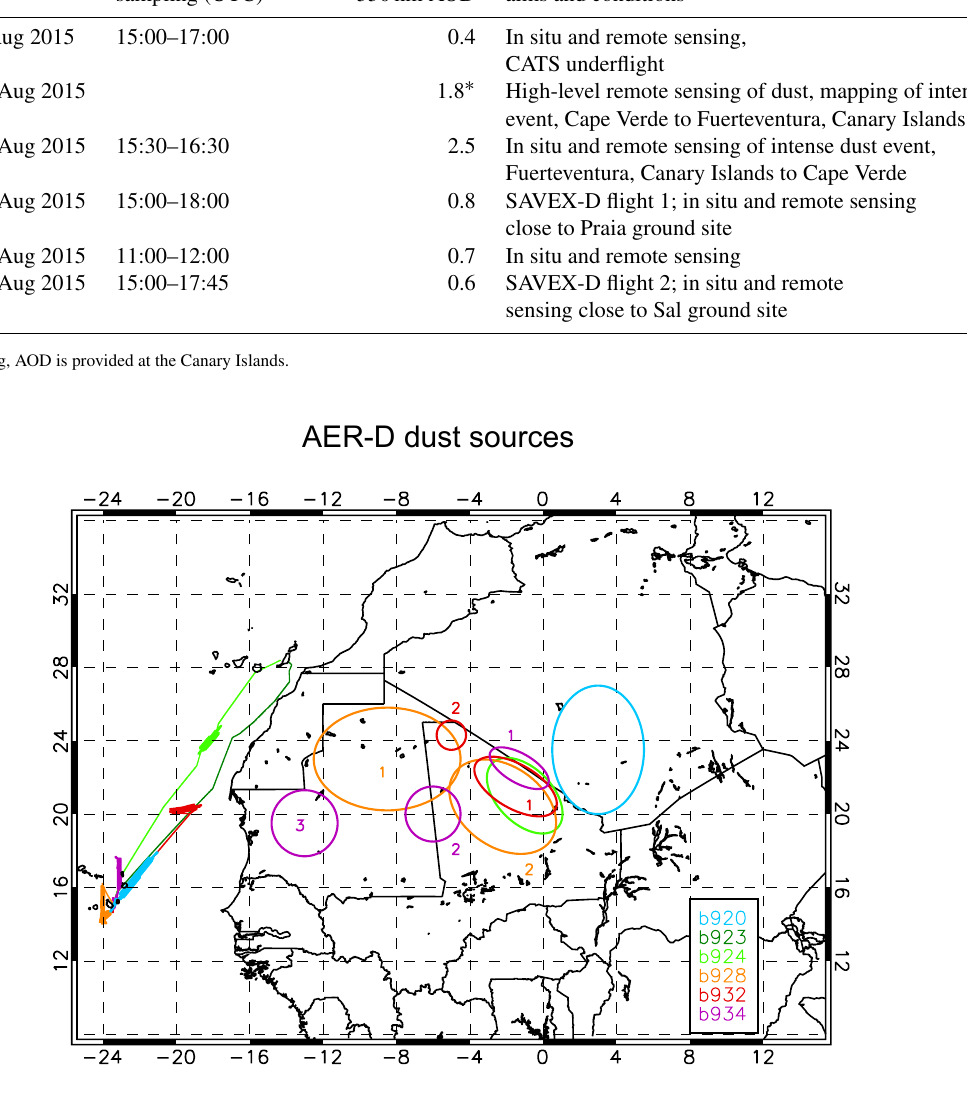
Figure 1. Map showing the location of the AER-D flights, out of Praia on Cape Verde. Thin lines show full flight tracks; bold sections indicate in situ sampling SLRs analysed here. Note that within each flight there were several SLRs at different altitudes, which overlie each other here. Circles indicate dust source locations. Numbers indicate primary, secondary and tertiary dust uplift (see Table 4) events. Note that flights b923/b924 sampled the same dust